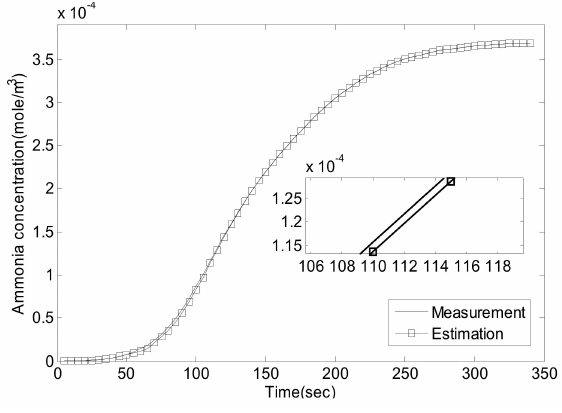
Figure 5. NO 2 / NO = 0 / 1, 30 ◦ C, comparison of C NH